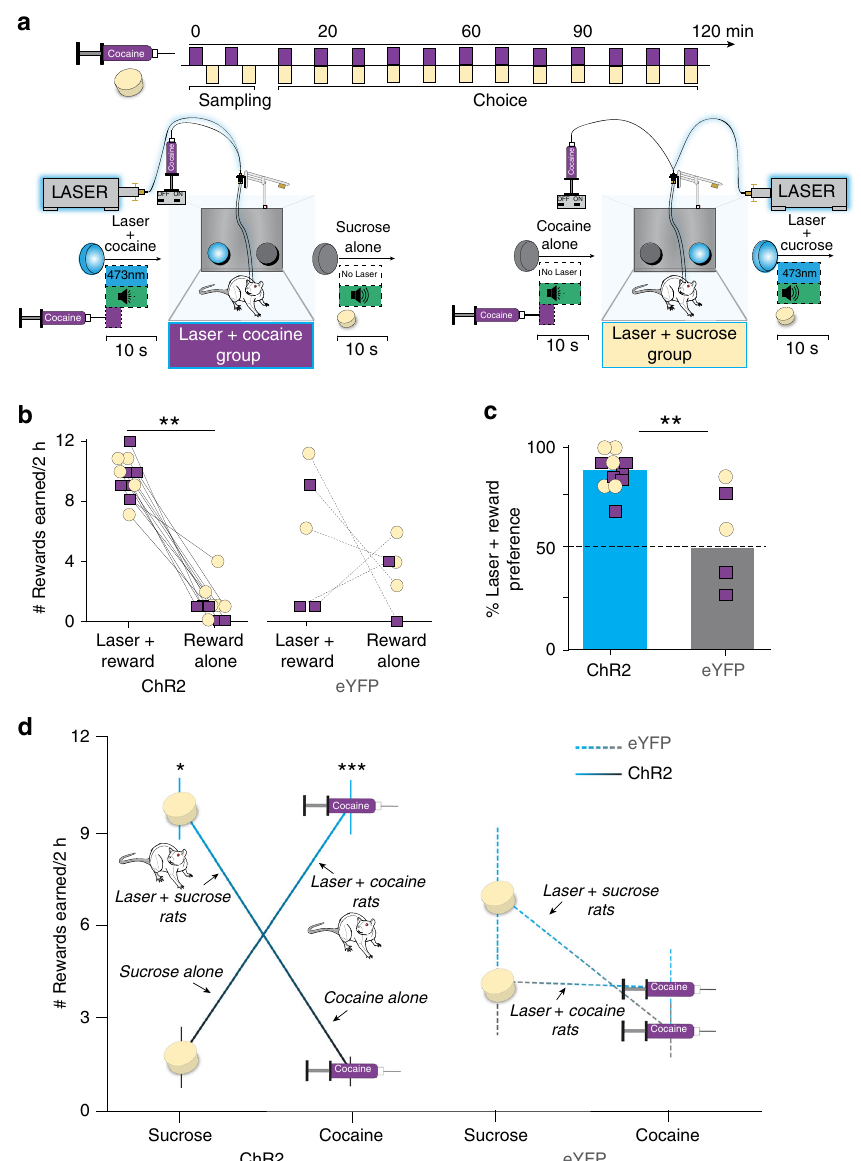
Fig. 2 CeA ChR2 pairing controls pursuit of sucrose vs. cocaine. a Sucrose – cocaine choice paradigm and timeline within an individual test session; nm, nanometers; s, seconds; min, minutes. b Earned rewards (via nosepokes on an FR1 schedule) during 2 h (h) sucrose vs. cocaine choice sessions. ChR2 rats, N = 11; eYFP rats, N = 5; two-way within and between subjects ANOVA, main effect of virus: F = 4.6, p = 0.046; ChR2 laser vs. nonlaser responses, 1,10 two-sided paired t -test, t 9 = 7.5, p = 0.000, 95% CI: 4.8, 9.2, d = 4.39. Individuals with laser-paired sucrose in yellow circles and cocaine in purple